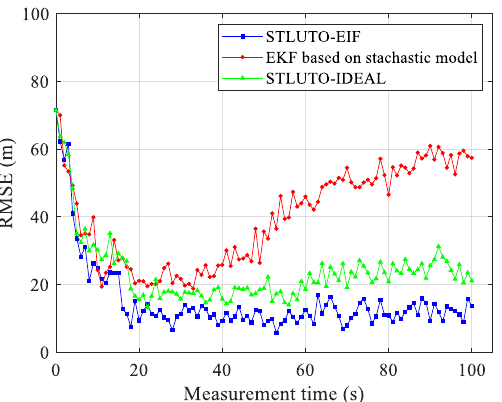
Figure 10. RMSE errors of target localization for the moving target with constant acceleration.